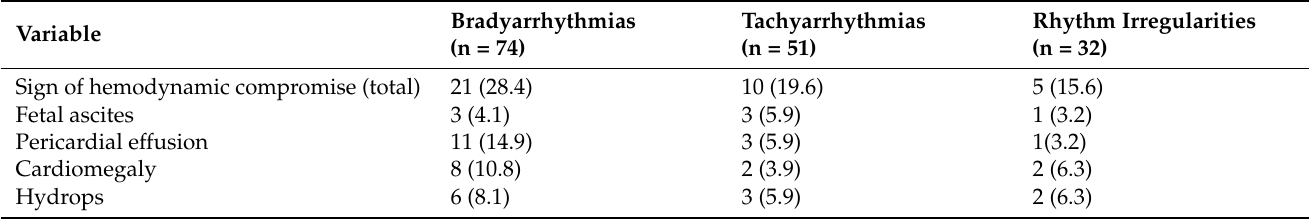
Table 3. Fetal signs of hemodynamic